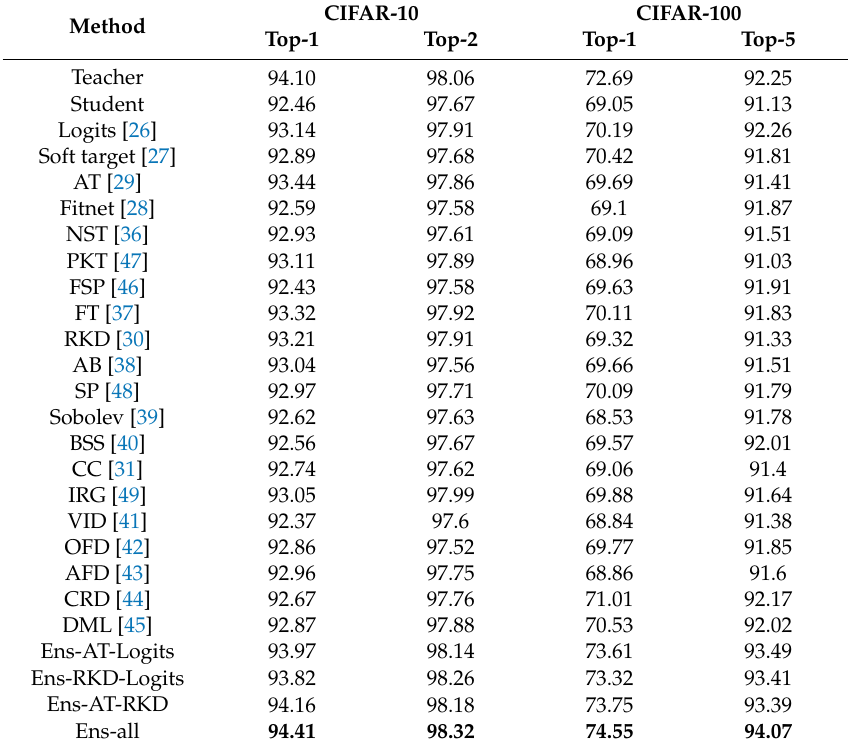
Table 1. Top- k accuracy (%) of knowledge distillation models and our proposed models on the CIFAR-10 and CIFAR-100 datasets. ( k = 1,2 on CIFAR-10 and k = 1,5 on CIFAR-100 where k is the number of top elements to look at for computing accuracy).